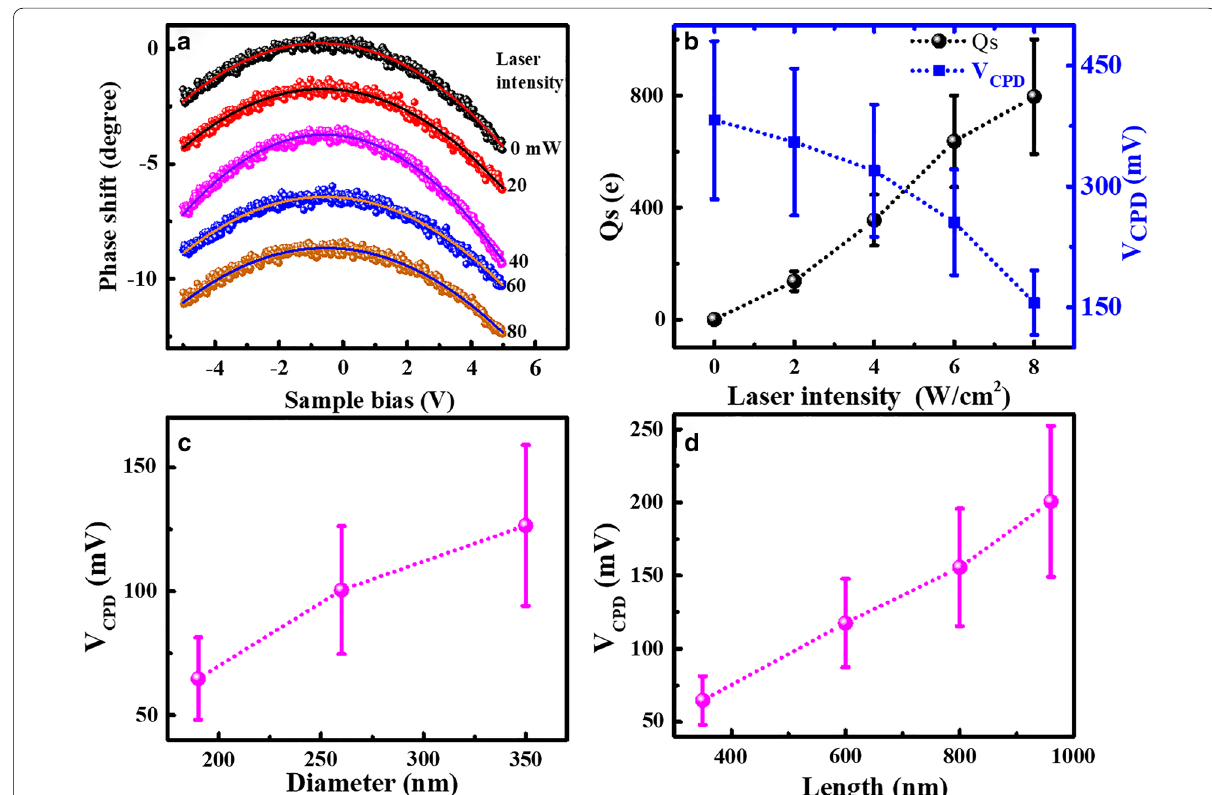
Fig. 6 a ∆ Φ ~ V EFM curves measured by EFM on individual Si NWs with the diameter of 190 nm and length of 800 nm under different laser irradiation. b The results of Qs and V CPD obtained by fitting the curves in a as a function of laser intensity. The diameter and length dependence of V CPD at the laser intensity of 8 W/cm 2 is presented in c , d ,